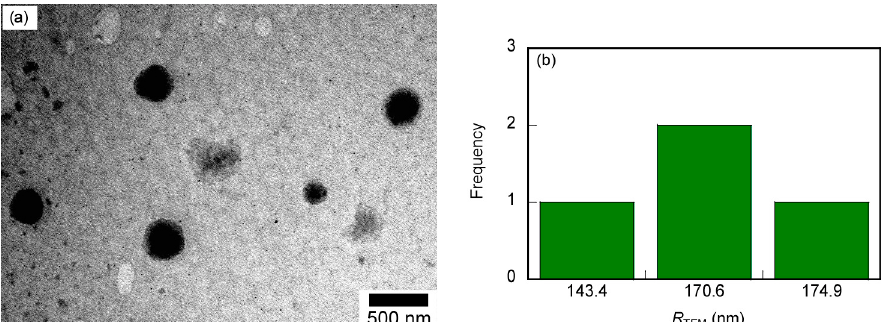
Figure 4. ( a ) TEM image and ( b ) histogram of particle size distribution of PSBP/CTAB complex with a mixing ratio of 0.5 within a complex concentration of 0.084 g/L in a 0.1 M NaCl aqueous